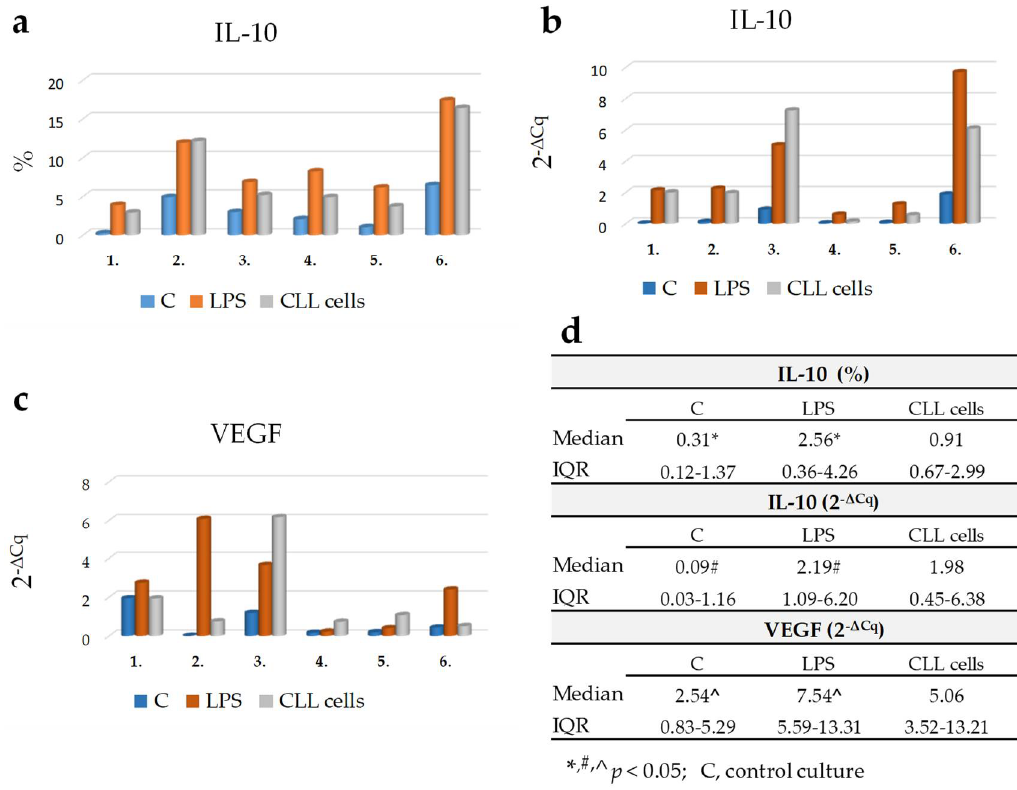
Figure 9. The effect of CLL cells on IL-10 or VEGF expression in monocytes from six healthy donors. ( a ) Percentage of Tie2+ monocytes with intracellular IL-10 expression (as assessed by flow cytometry). ( b ) Quantitative expression of IL-10 mRNA and ( c ) VEGF mRNA (data are presented as 2 - ∆ Cq ). ( d ) Statistical analysis. The data are presented as the median and interquartile range (IQR: 25% percentile and 75% percentile). Monocytes from healthy donors were cultured alone (basal expression; control culture (C) without stimulation; blue column), LPS—stimulated (positive control; red column) or cultured in direct contact with CLL cells (grey column). Each number under the graphs represents a set of related data for an individual healthy donor.